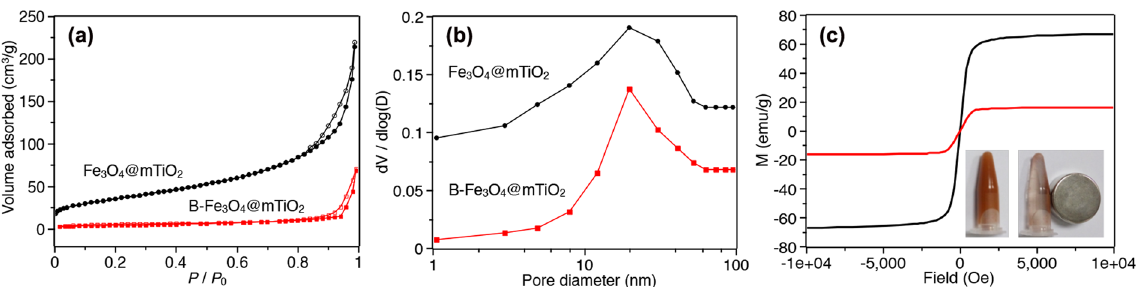
Figure 4. N 2 adsorption-desorption isotherms ( a ) and pore-size distribution curves ( b ) for Fe 3 O 4 @mTiO 2 and